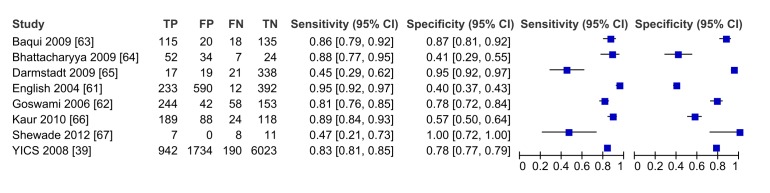
Forest plot of studies of diagnostic accuracy of frontline health worker diagnosis of pBI compared to physician diagnosis.